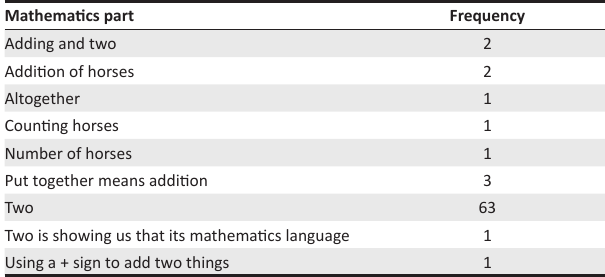
TABLE 2: Mathematics part of ‘Boxer was as strong as any two ordinary horses put together’. Mathematics part